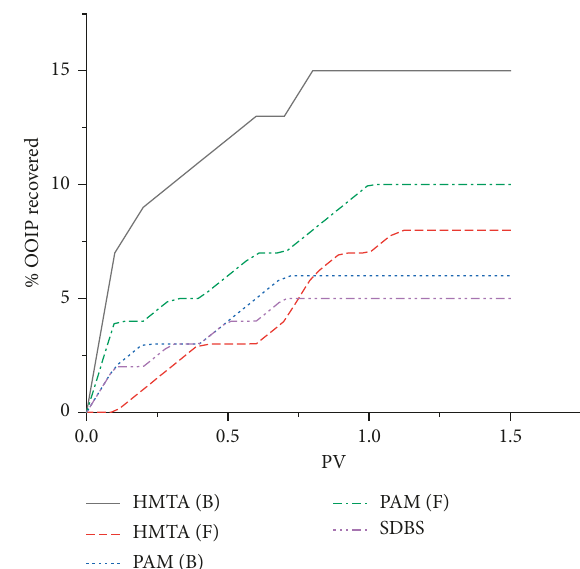
Figure 6: Oil recoveries versus volume of surfactant